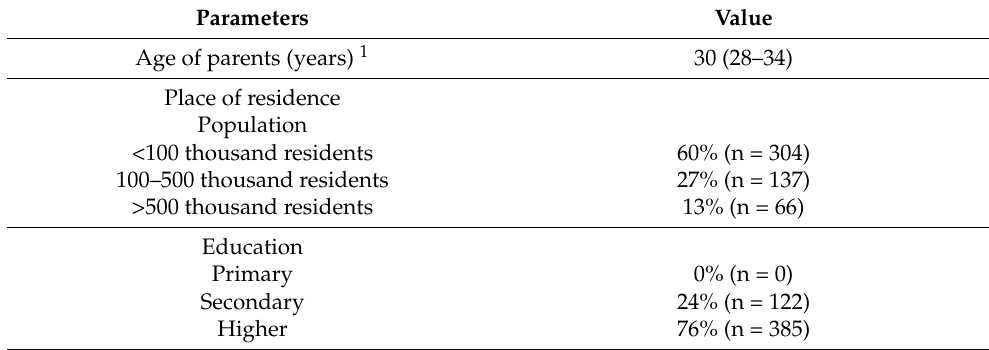
Table 1. Data covering parents’ age, education, and place of residence and children’s age and